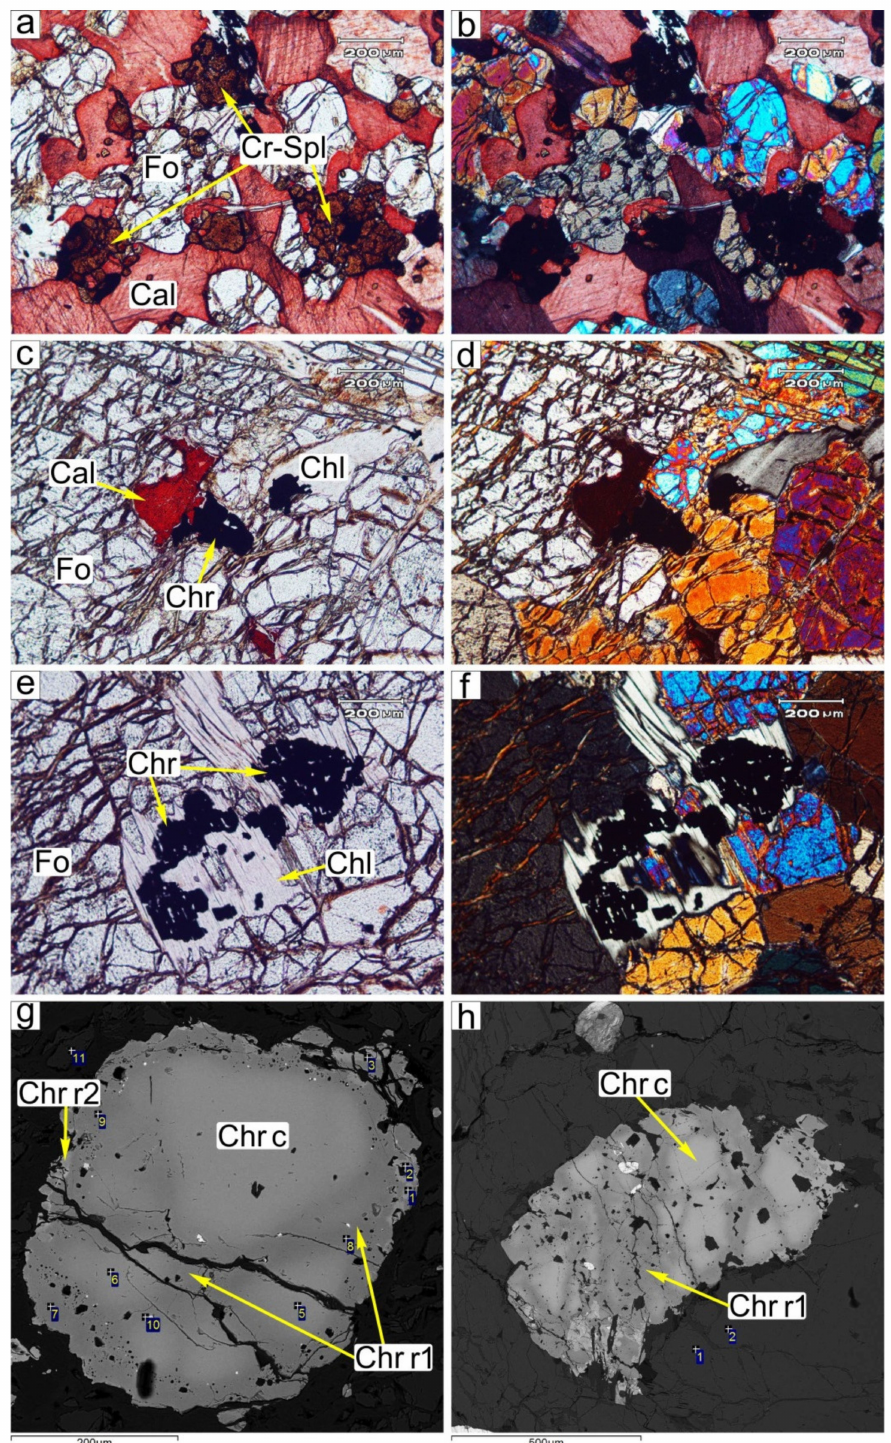
Figure 8. Microphotographs ( a – f ) and back-scattered electron (BSE) images ( g , h ) of ultramafic rocks. ( a , b ): calcite–forsteriterocksatthecontactoftheSakhyurtaperidotitewithmarble(cross-polarizedlight); ( c , d ): calcite-bearing dunite at 3 m from the contact with marble, Sakhyurta peridotite; ( e , f ): chrome spinel aggregate in chlorite (Tog dunite); ( g , h ): zoned Cr spinel in chlorite (Tog dunite). Amphibolites are widespread within the terrane, but their interpretation as ophiolite metavolcanics or metagabbro is questionable. The ophiolitic nature of the exposed amphibolites can hardly